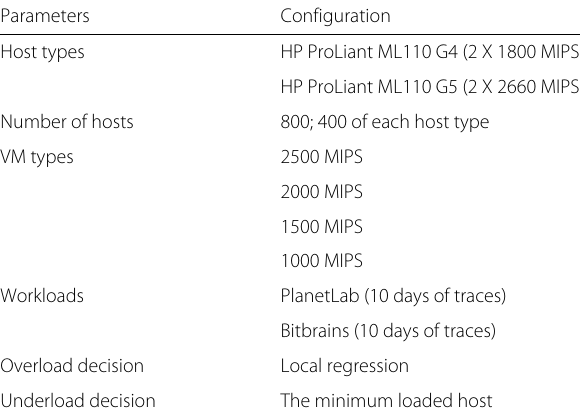
Table 1 Default-scenario parameters and